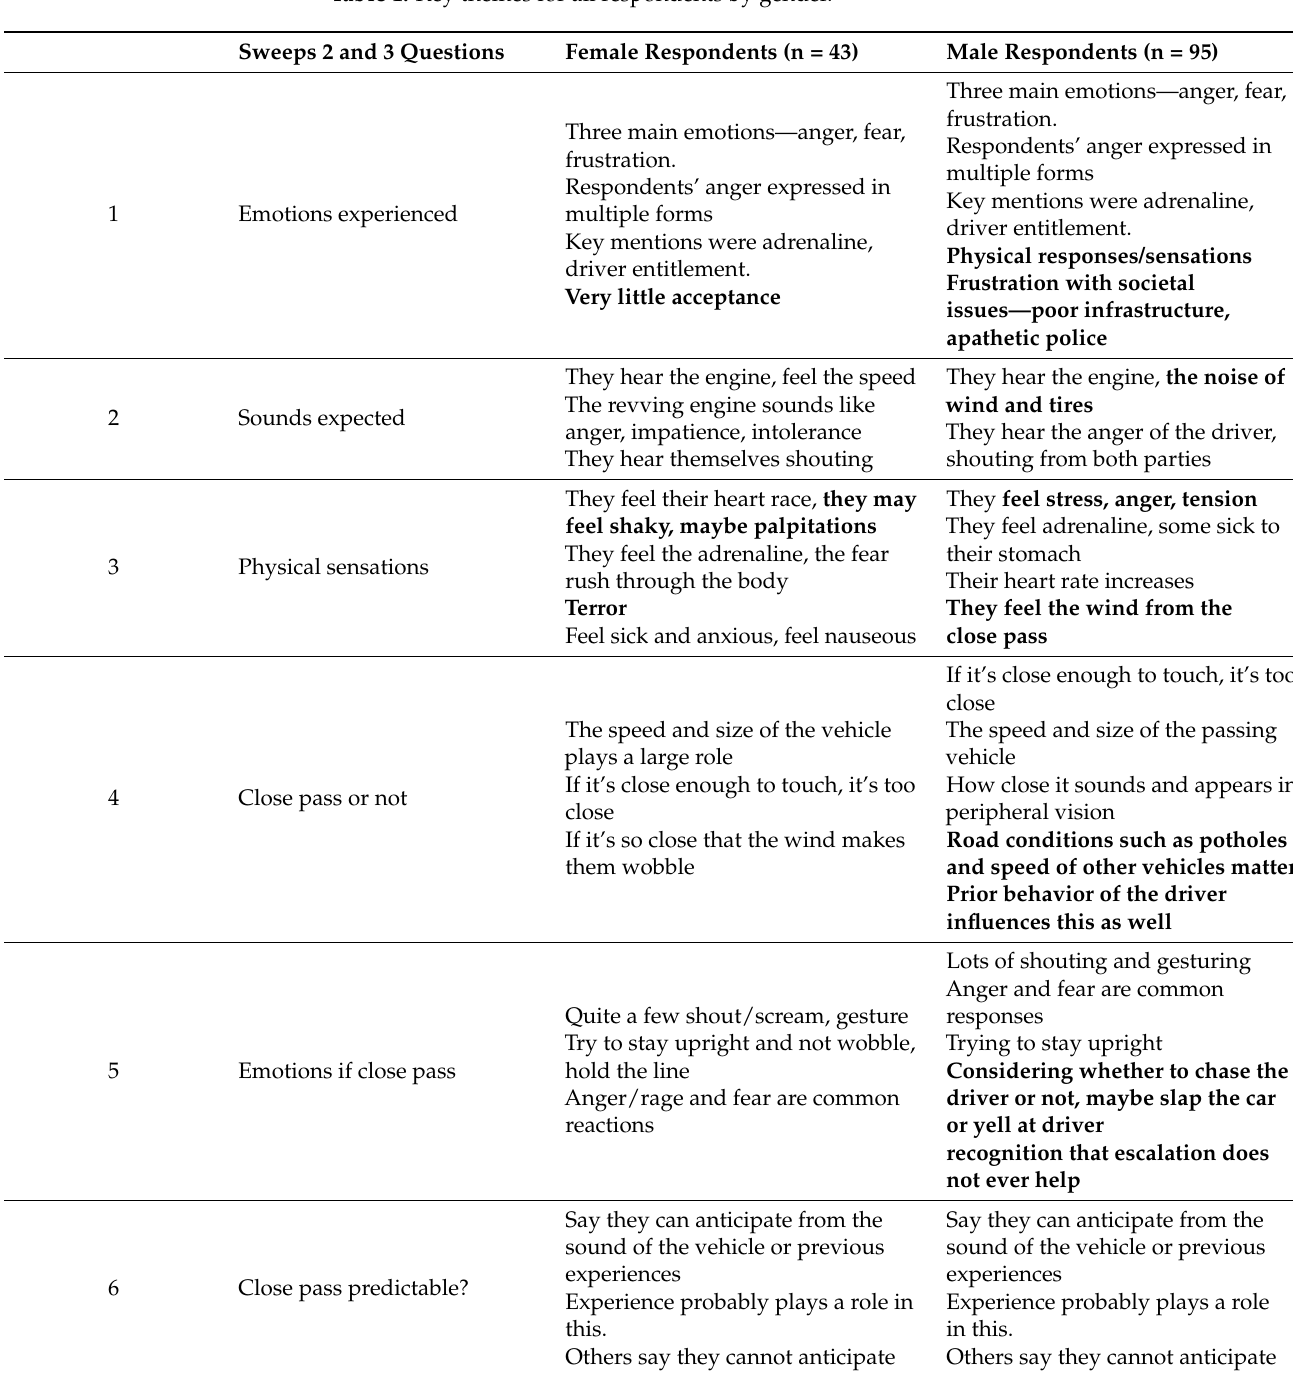
Table 1. Key themes for all respondents by